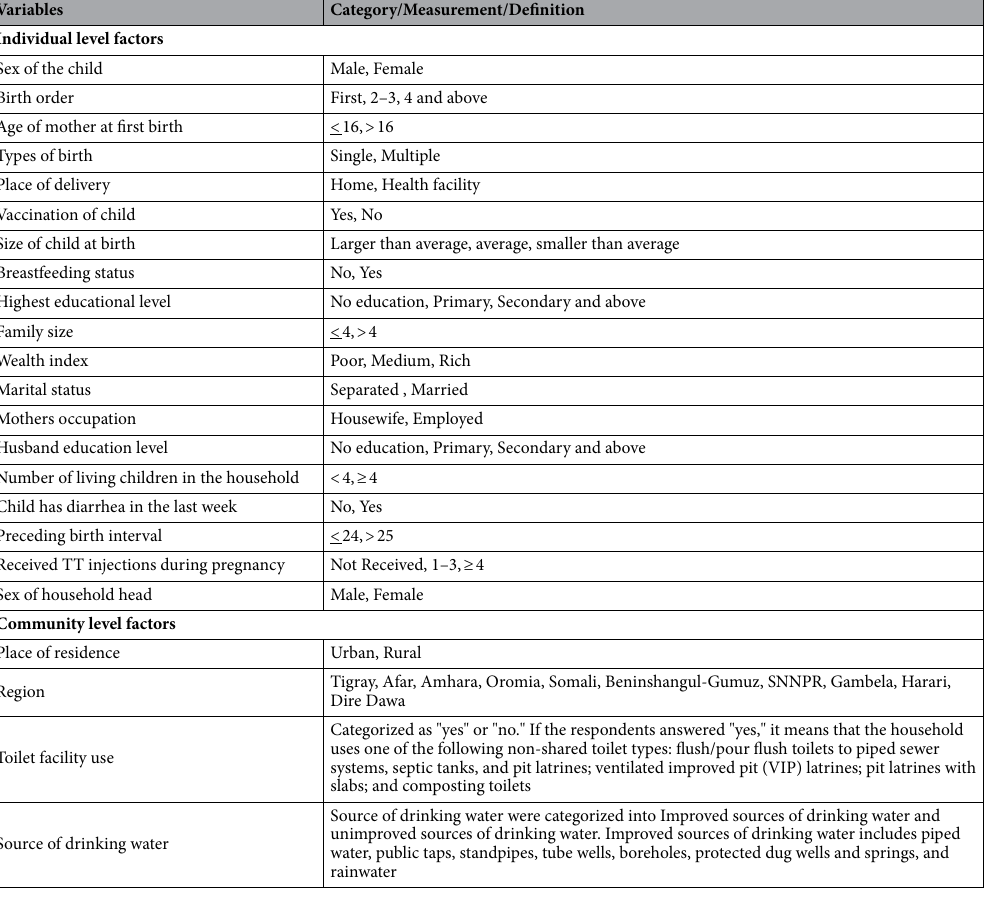
Table 1. Description and measurement of individual- and community-level independent